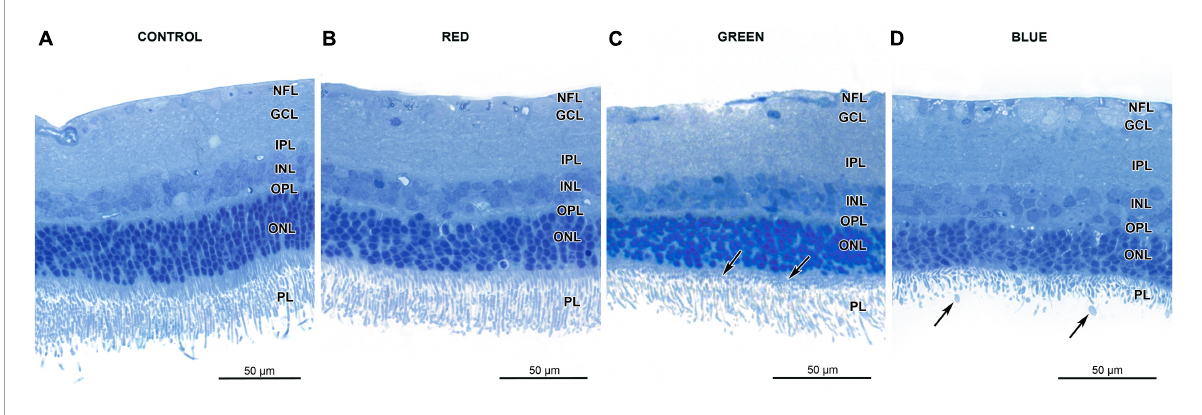
FIGURE1 Effect of monochromatic light exposure on the retinal morphology of Wistar rats. The rats were exposed to 12 h white light (150 lx) and 12 h darkness for 7 days (control, 32 rats), 12 h red light (150 lx) and 12 h darkness for 7 days (red-light group, 32 rats), 12 h green light (150 lx) and 12 h darkness for 7 days (green-light group, 32 rats) and 12 h blue light (150 lx) and 12 h darkness for 7 days (blue-light group, 32 rats). The figure presents retinal sample collected at 11:00. Resin-embedded semithin sections were stained with toluidine blue and visualized with light microscope (AxioImager, Zeiss). Retinas from the control (A) , red-light (B) groups display normal morphology. The photoreceptor inner segments in retinas from green-light group are shorter than those of control group (arrows) (C) . Retinas from the blue-light group display loss and vesiculation of photoreceptor outer segments (arrows) (D) . Note thinner outer nuclear layer in this